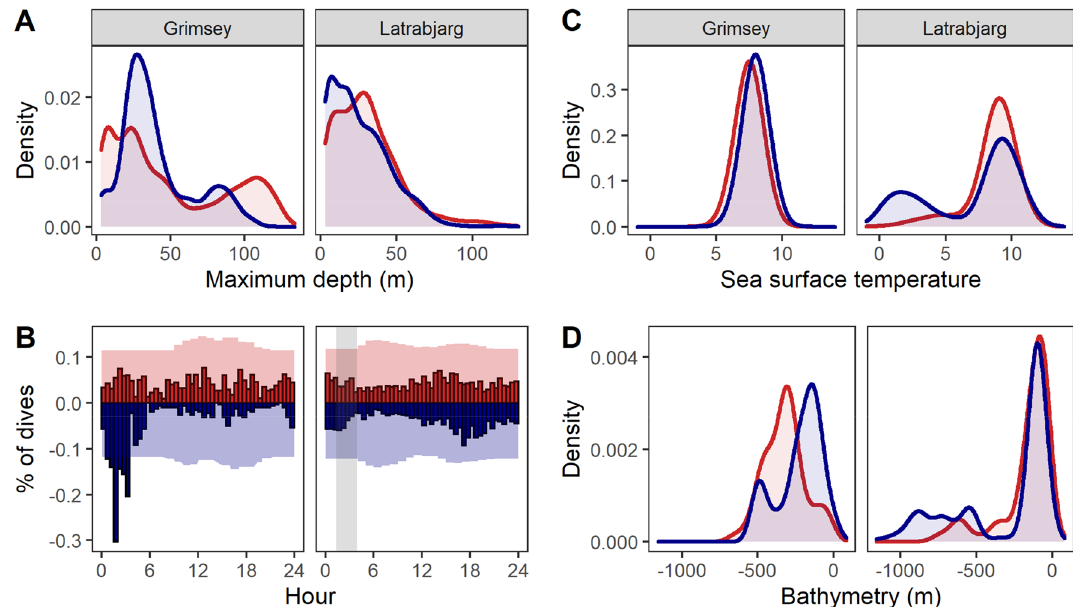
Figure 2. Diving behaviour and conditions at dives across colonies and species (red: common guillemot; blue: Brünnich’s guillemot). ( A ) Distribution of maximum dive depth; ( B ) Diel distribution of the occurrence of dives; shaded areas: relative distribution of tracking effort (hours in GMT); grey areas: times between sunset and sunrise (averaged over all deployment dates for each site). ( C ) Sea surface temperature (°C); ( D ) Bathymetry (m). Values averaged across diving sections (series of dives separated by flight).